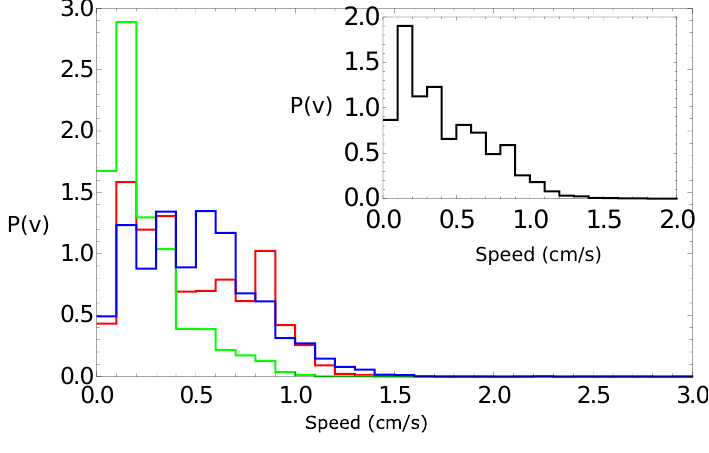
Figure 4. The speed of a pill made of 95% camphene and 5% polypropylene as a function of time, as observed in the three independent experiments.